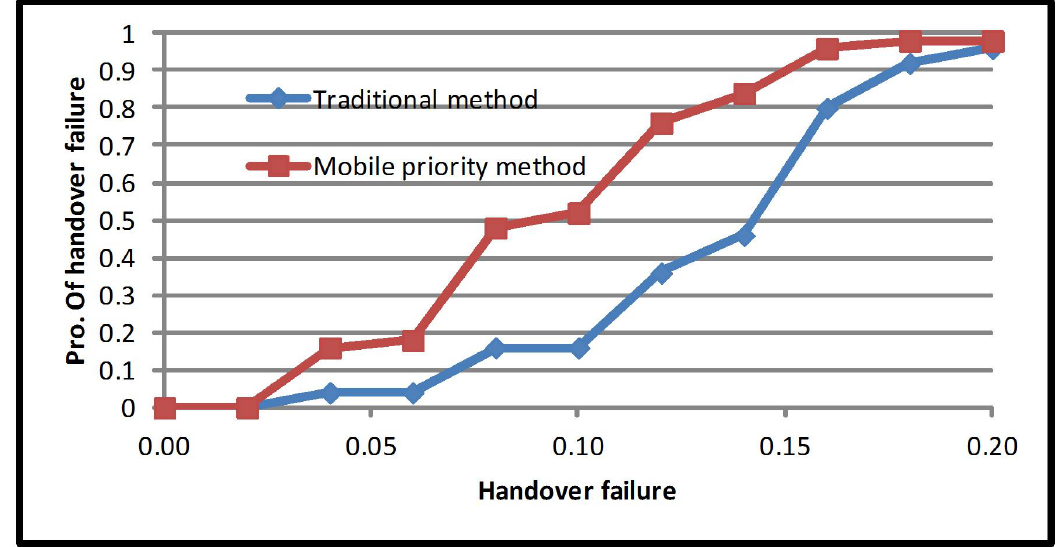
Figure 6. Average handover failure probability of the mobile priority method.